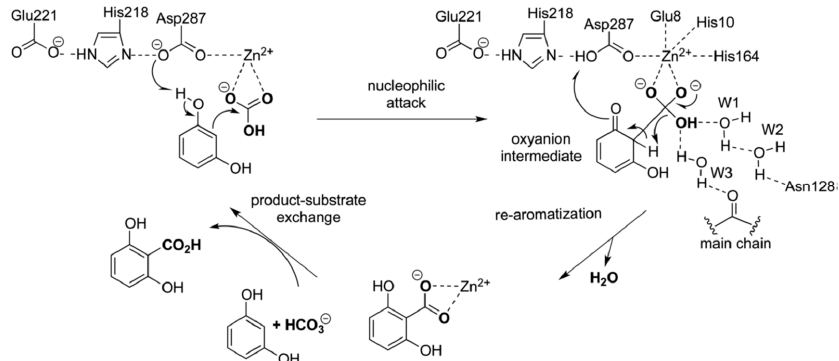
Figure 10. Proposed catalytic mechanism for the ortho -carboxylation of resorcinol based on the crystal structure of 2,6-dihydroxybenzoate decarboxylase from Rhizobium sp. 38 (Protein Data Bank (PDB)-Code: 2DVU) supported by docking experiments. Adapted with permission from [45]. Copyright 2014, Royal Society of Chemistry.